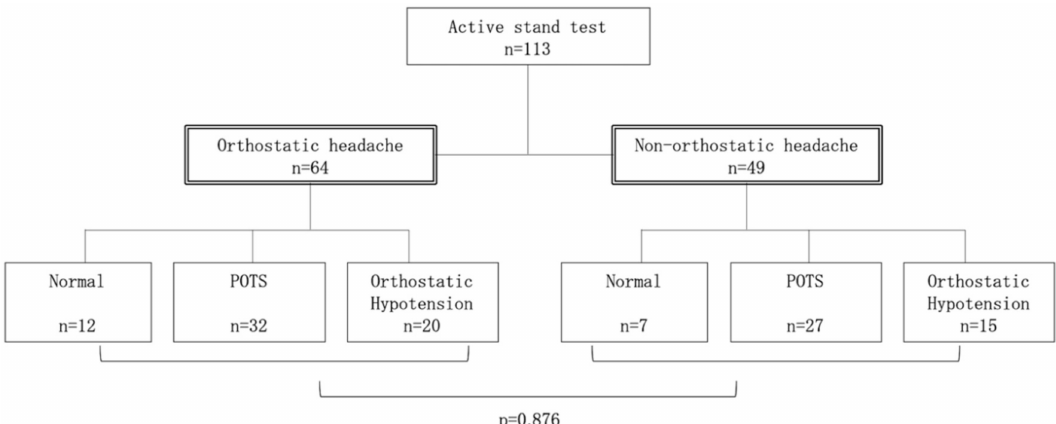
Figure 1. Categorization of participants, orthostatic headache, and autonomic disorders. The inclusion criteria were met by 113 subjects who subsequently underwent the active stand test, including 64 in the orthostatic headache group and 49 in the non-orthostatic headache group. Postural tachycardia syndrome (POTS) was found in 32 subjects (50.0%) in the orthostatic headache group, and 27 subjects (55.1%) in the non-orthostatic headache group. Orthostatic hypotension was found in 20 (31.3%) and 15 (30.6%) subjects in the orthostatic headache and non-orthostatic headache groups, respectively. No statistically significant di ff erence was observed between groups ( p = 0.876). Values indicate the number of subjects. Statistical analysis was performed using the chi-squared test. p < 0.01 was considered to indicate statistical